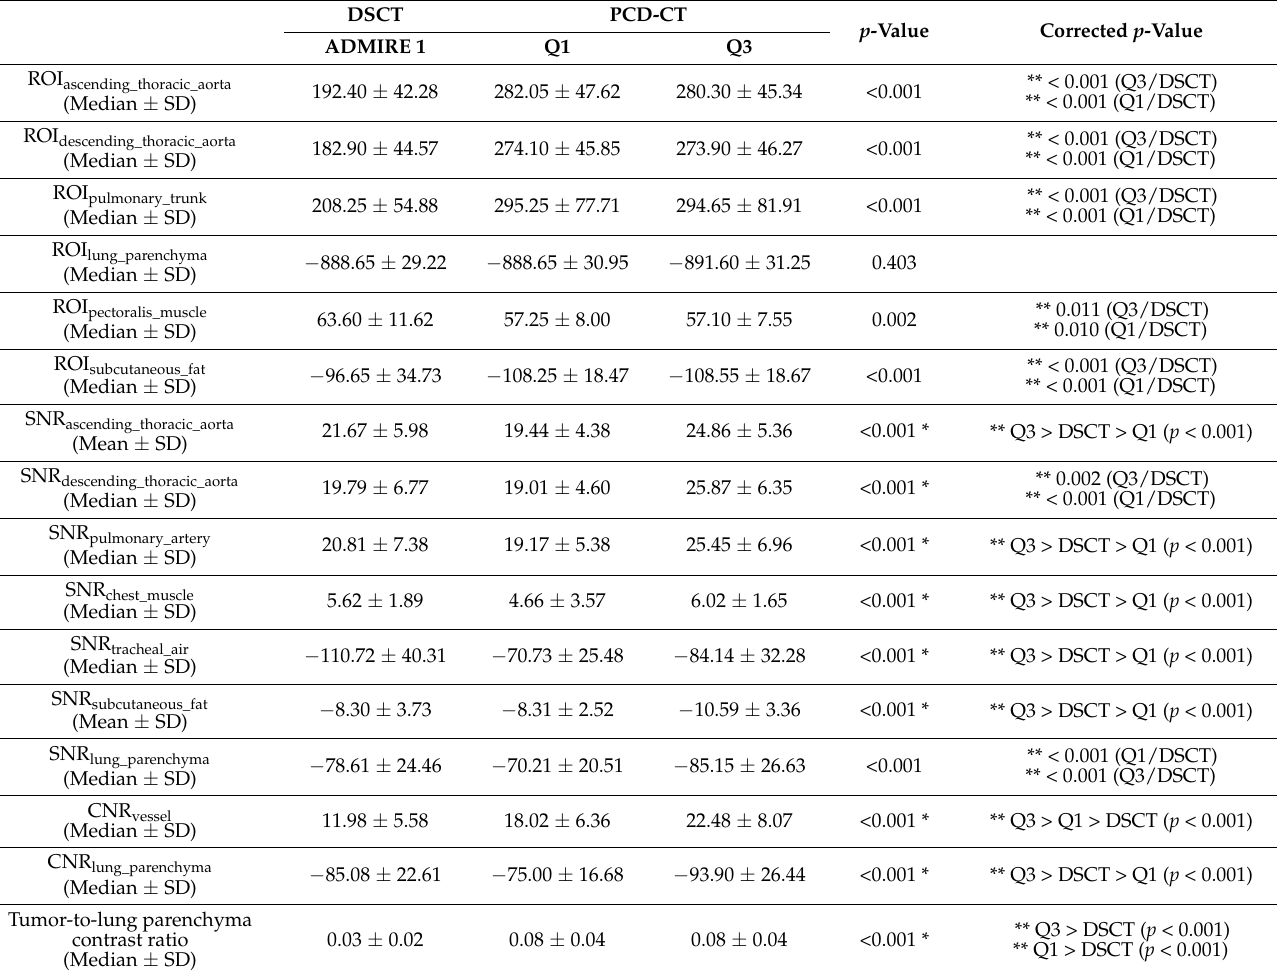
Table 3. Comparison of the objective image quality between DSCT und